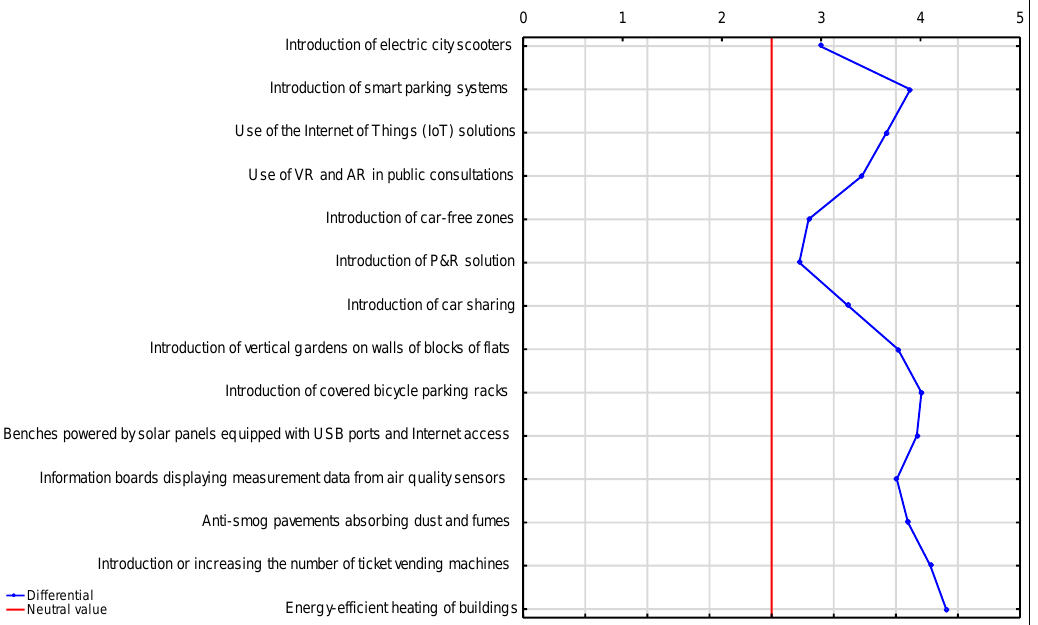
Figure 15. Semantic differential for the assessment of the relevance of introducing smart solutions in the city of Suwałki. Source: own study based on questio nnaire surveys.